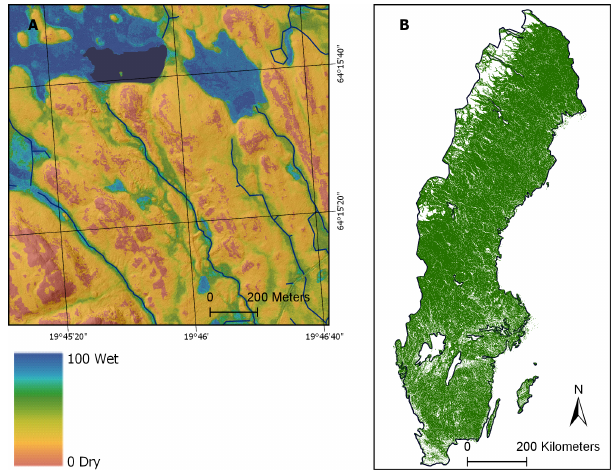
Figure 2. (a) Example of the SLU soil moisture map showing the probability of a soil being wet (0%–100%) (Ågren et al., 2021). (b) Green areas indicate the forest landscape in Sweden that is sampled by the Swedish National Forest Inventory (Fridman et al., 2014) and the Swedish Forest Soil Inventory (Olsson, 1999; Sten- dahl et al.,